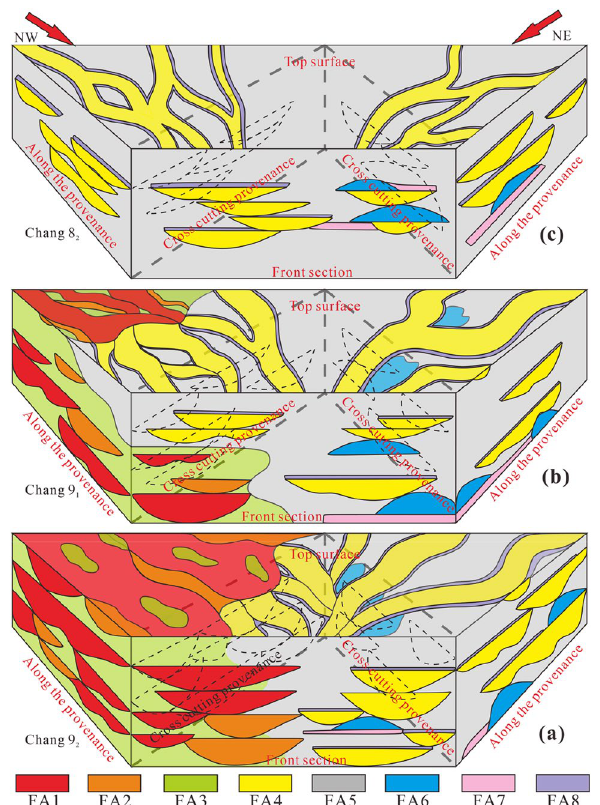
Figure 17. Spatial distribution pattern of all architectural elements.